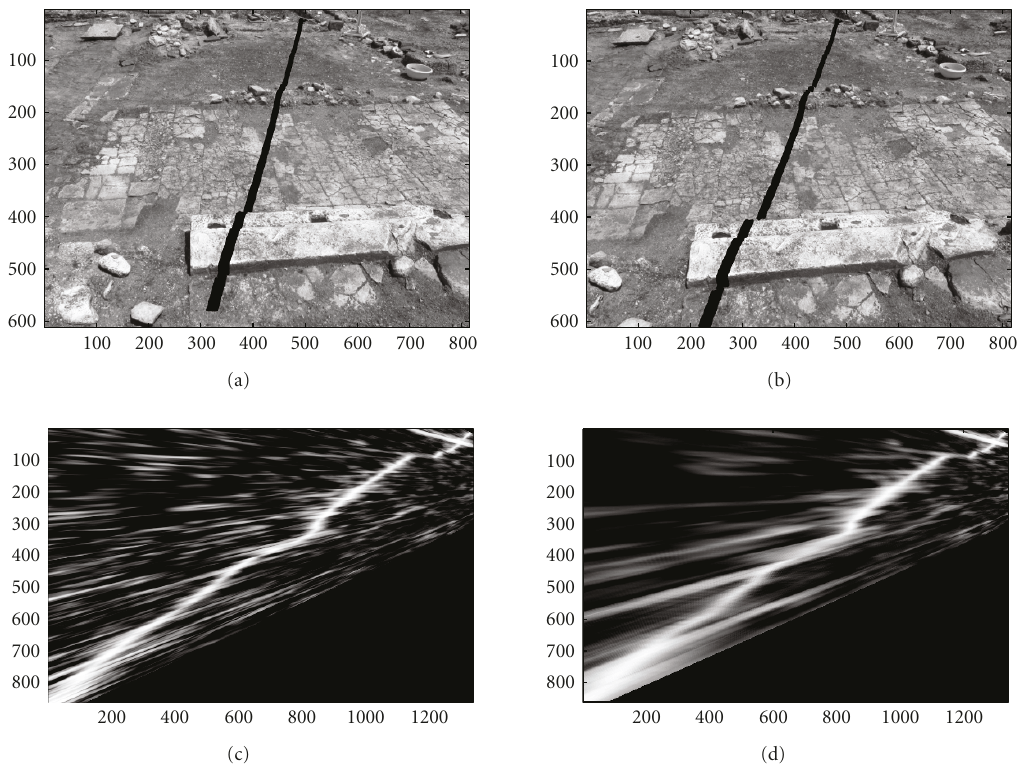
Figure 6: Shown on the top row is a stereo pair and on the bottom row two separate calculations of s across a vertical section, along the xx (cid:2) axis of the scene. The section is indicated on the top row images by projecting the reconstructed points along this section back to the original images. In the bottom row, the left image corresponds to a constant α and the right to a size-modulated α